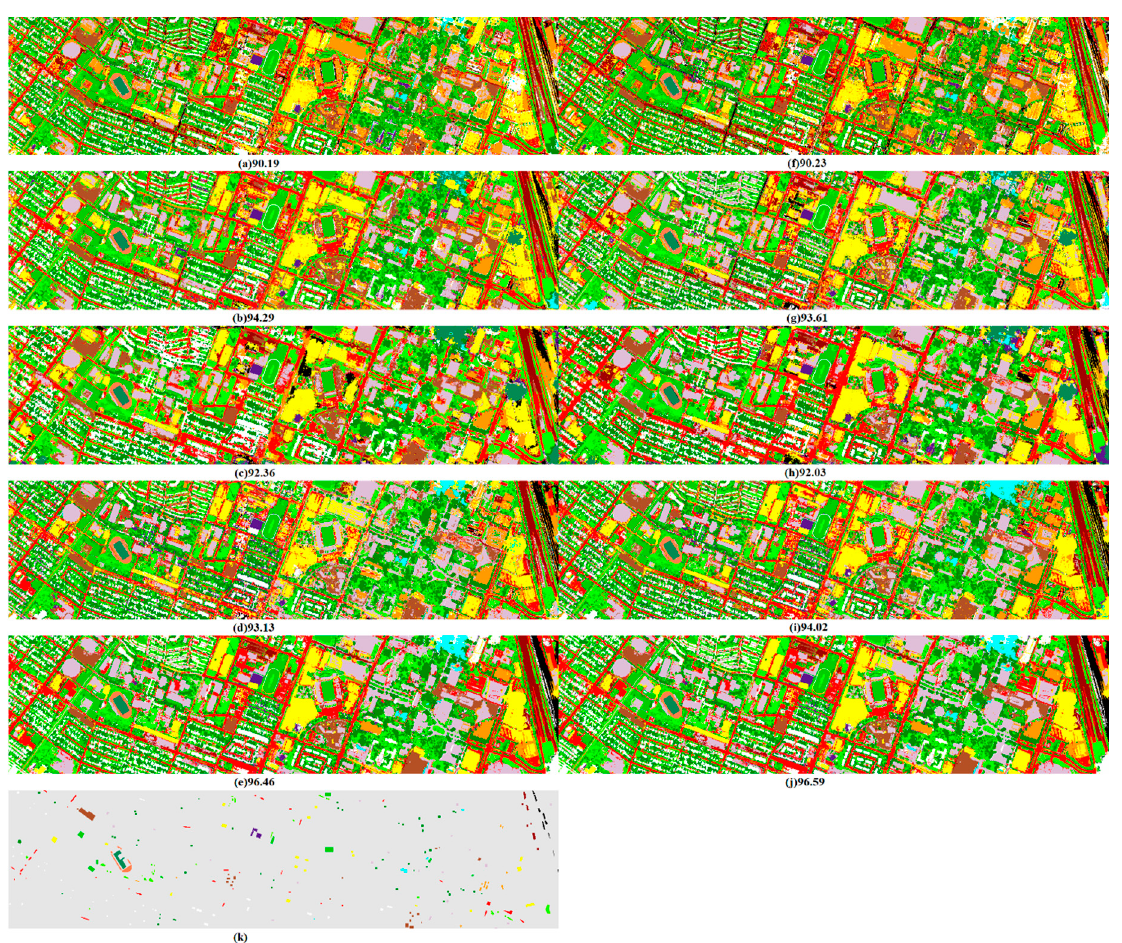
Figure 7. Classification maps with OA values ( a – j ) corresponding to Table 2 and ground truth map, ( k ) for comparison with GRSS ‐ DFC2013 test data.